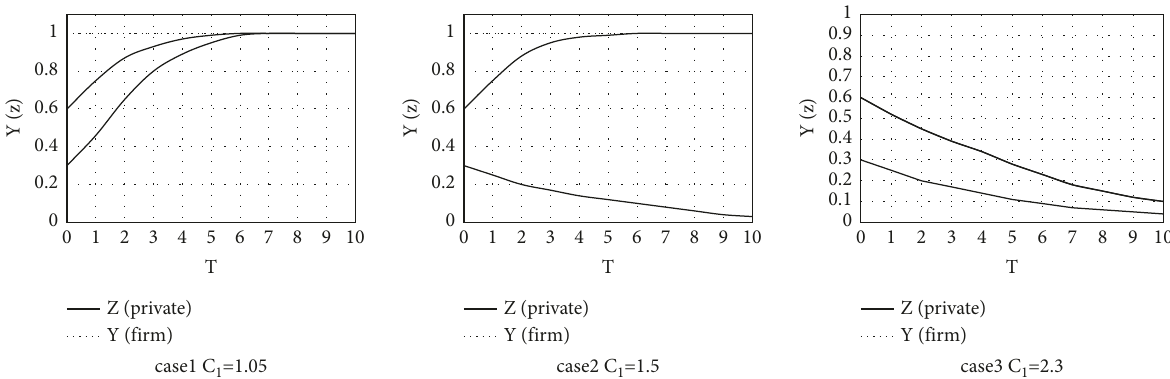
Figure 4: C 1 impact of changes on the evolution of co-created